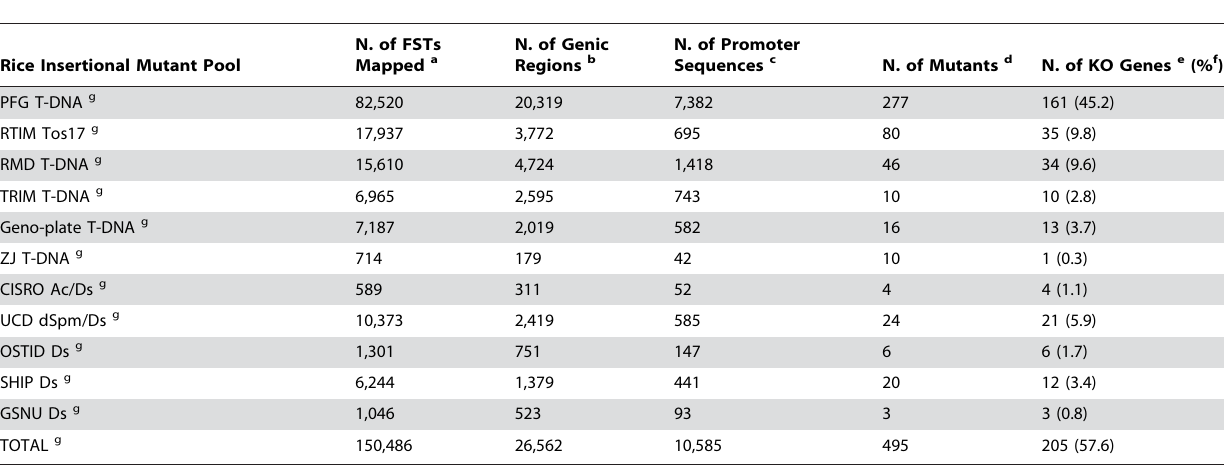
Table 1. Rice Insertional Mutant Pools Available and Estimation of Coverage for 365 Light-responsive Candidate Genes Showing at least 8-Fold